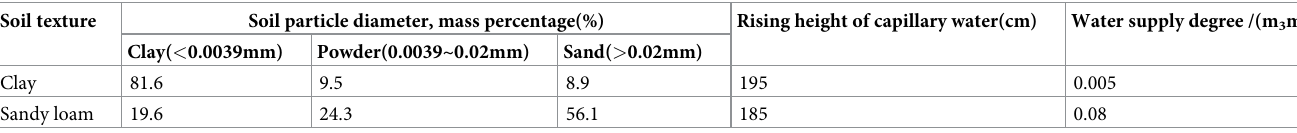
Table 1. Clay and sandy loam soil parameters. Soil texture Soil particle diameter, mass